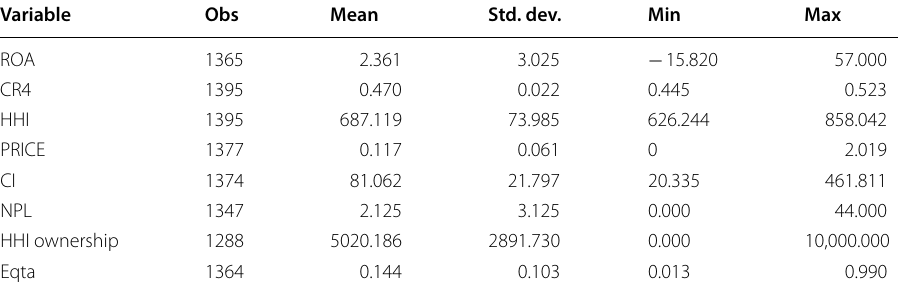
Table 1 Data summary. Source: Author’s calculation on data provided by the Indonesia Financial Services Authority